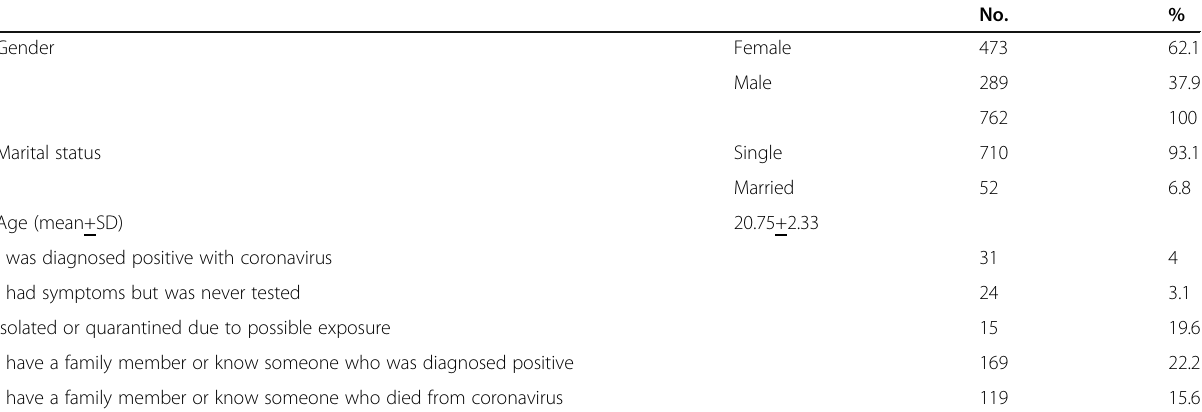
Table 1 Socio-demographical characteristics of the sample